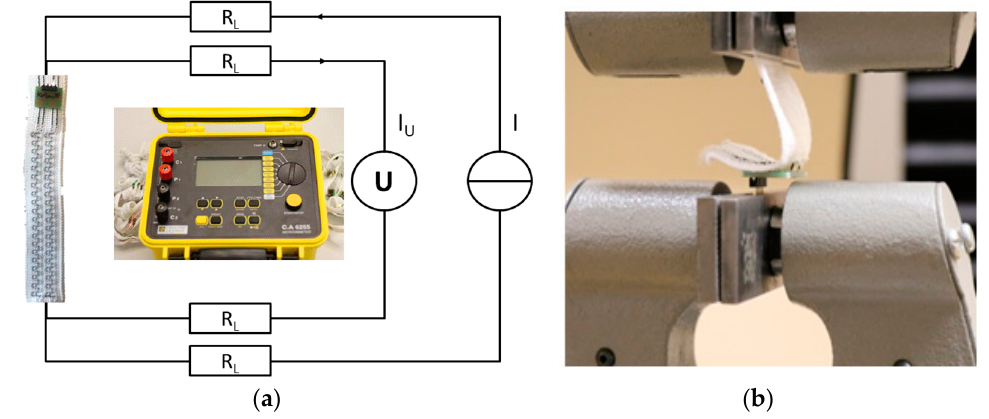
Figure 3. ( a ) Measuring setup for determining the contact resistances by using the four-wire meas- urement principle; ( b ) Peeling test set-up: The PCBs are fixed in the blank and pulled on the contacted textile bands with a speed of 100 mm/min [27].